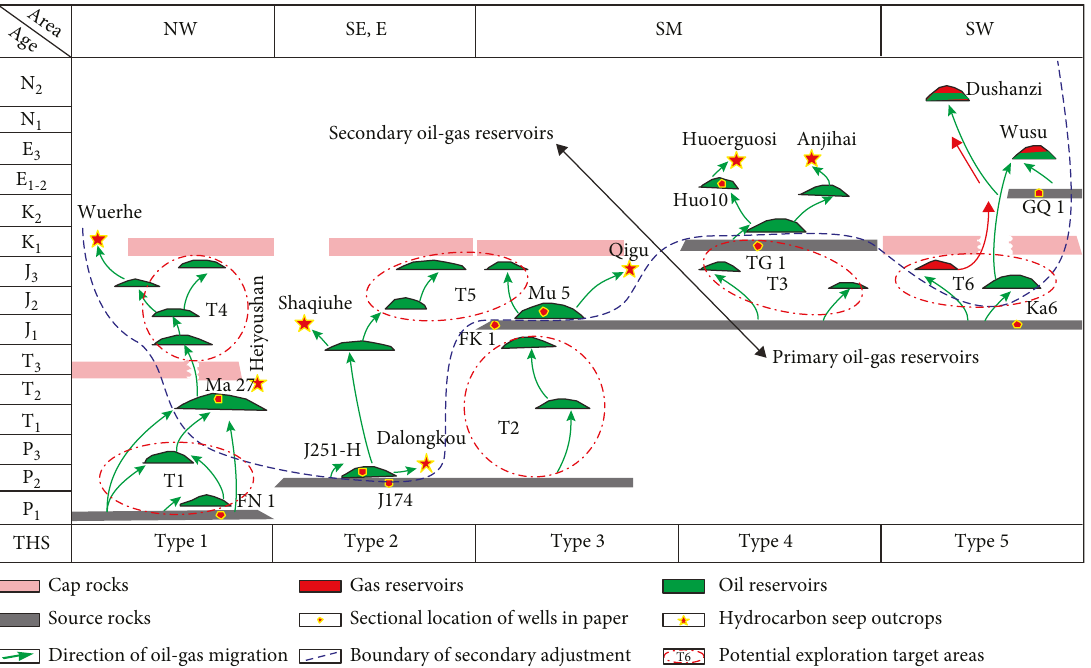
Figure 13: Genetic model of oil and gas seeps and its implications for hybrid petroleum systems of the Junggar Basin. THS: types of hydrocarbon